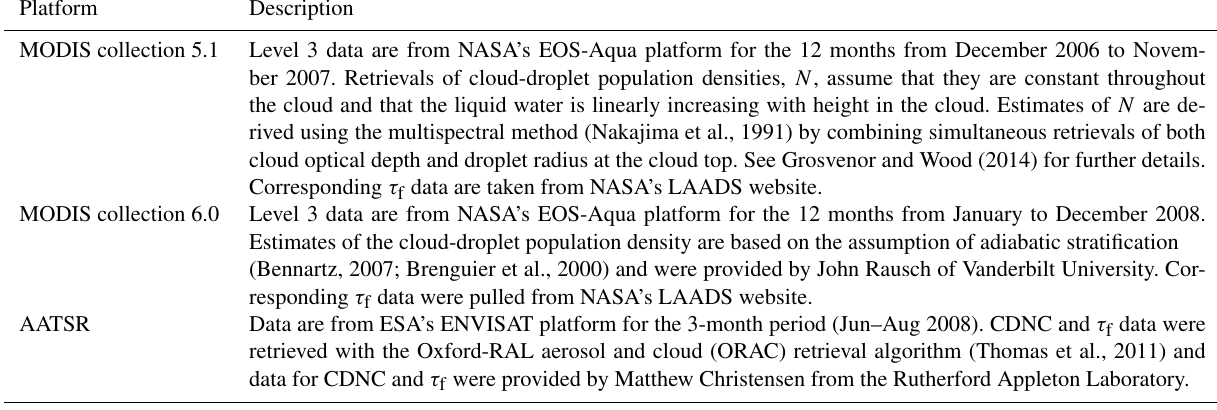
Table 3. Satellite data used to evaluate the relationship between fine-mode optical depth and cloud-droplet population density.